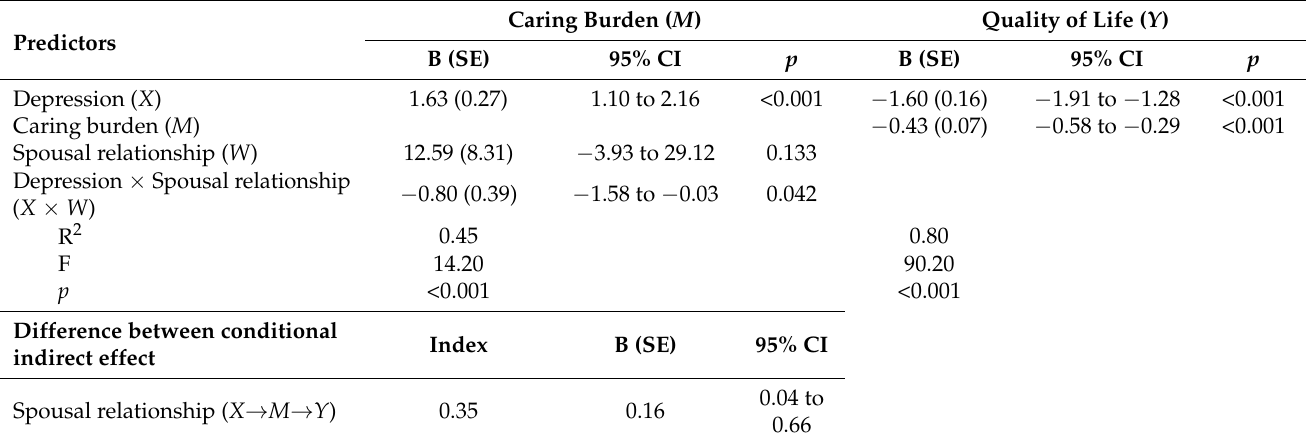
Table 3. Indirect effect of depression on quality of life mediated by caring burden and moderated by spousal relationship with patient (Model 7).